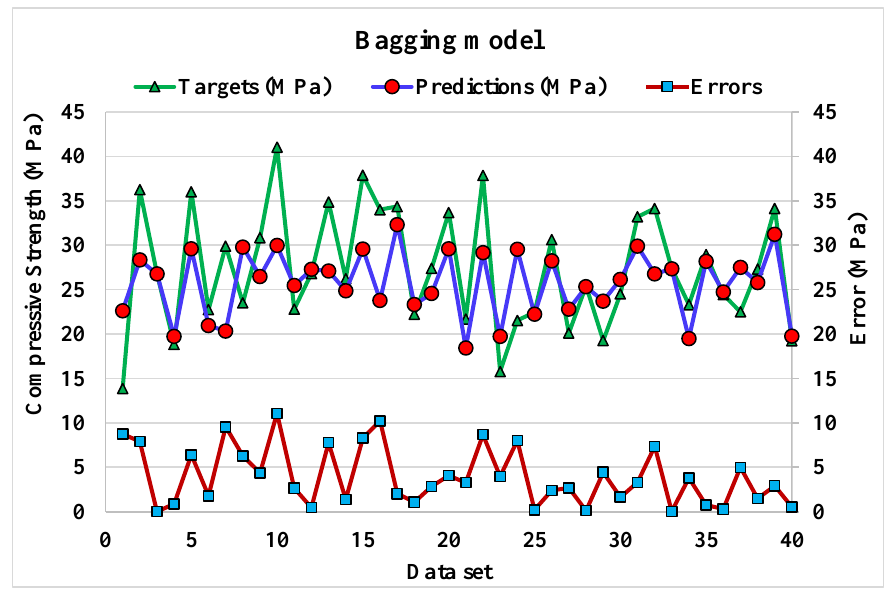
Figure 17. Dispersion of predicted and actual values along with errors for bagging model.